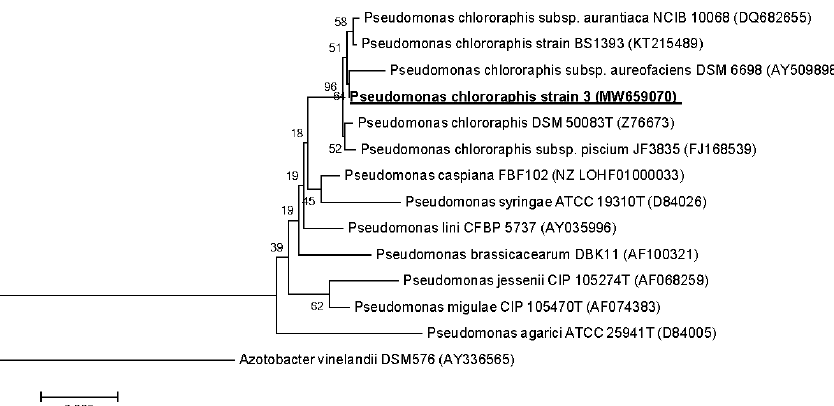
Figure 7. Phylogenetic position of strain Pseudomonas chlororaphis 3 based on the results of the comparative analysis of the nucleotide sequences of the 16S rRNA genes. The scale corresponds to 5 nucleotide substitutions per every 1000 nucleotides (evolutionary distance). The neighbor-joining method was used. The root was determined by including the sequence of Azotobacter vinelandii DSM576 (AY336565) as an external group.